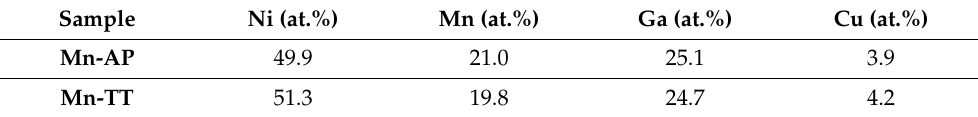
Table 1. The chemical composition for as-prepared (Mn-AP) and thermally treated (Mn-TT) ribbons.